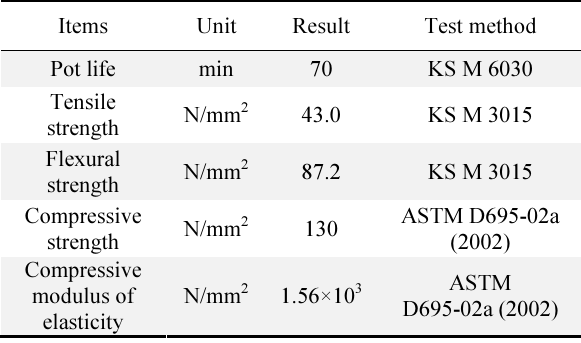
Table 3. Specifications and testing standards of the matrix